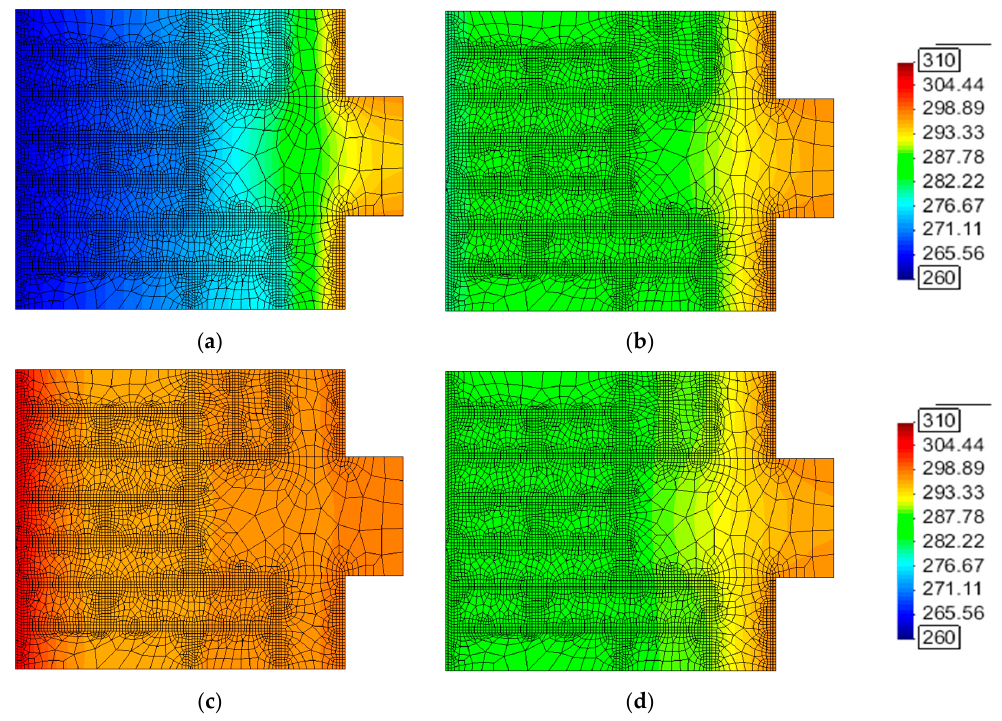
Figure 10. Temperature distribution (K) over the masonry and wooden beam end provided with interior thermal insulation made of wood fibers: ( a ) 9 January, 16:00, ( b ) 10 April, 22:00, ( c ) 11 July, 11:00, and ( d ) 10 October, 10:00. The temperature values were obtained using computational modeling technique described in Section 4.